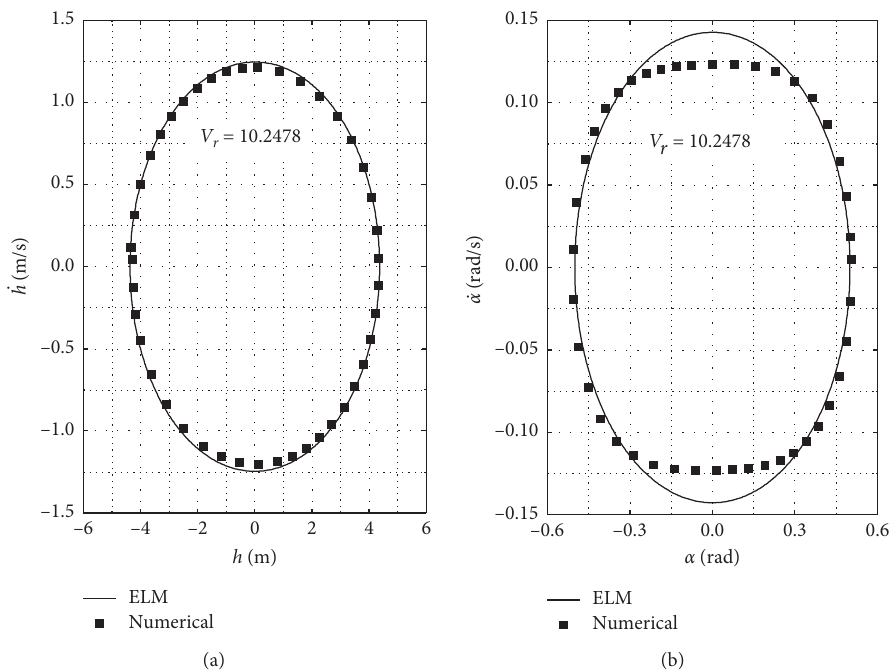
Figure 9: Limit cycle oscillation (LCO) vs. numerical solutions. (a) LCO in the vertical degree. (b) LCO in the torsional